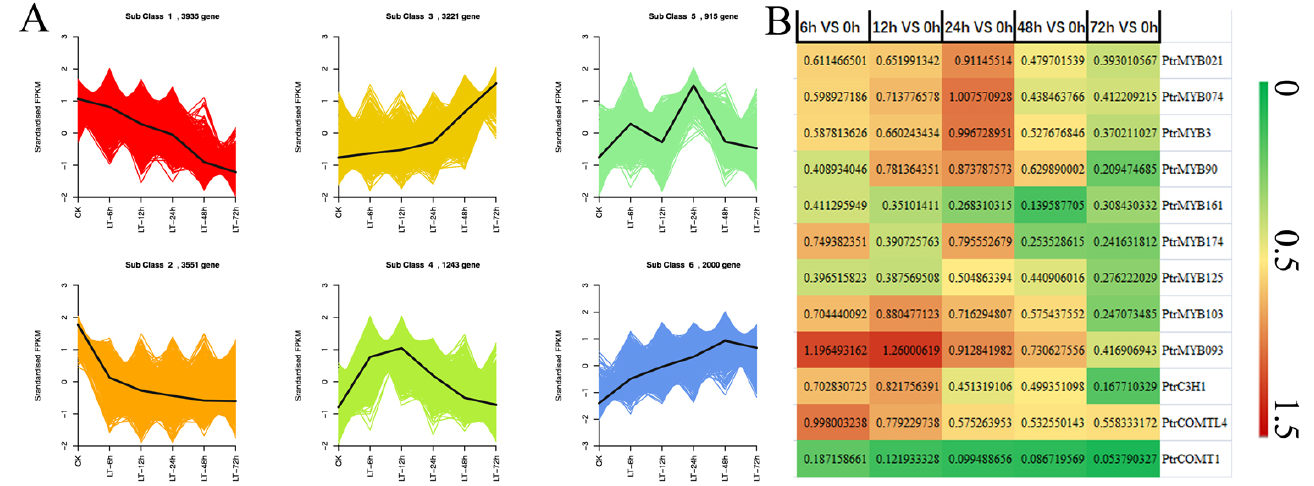
Figure 4. Analysis of gene expression in response to low temperature. ( A ) The expression patterns of DEGs analyzed by express trend model profile. ( B ) The expression level of some lignin-related genes at different time periods (6, 12, 24, 48, 72 h) compared with the control group (0 h) after low- temperature treatment.